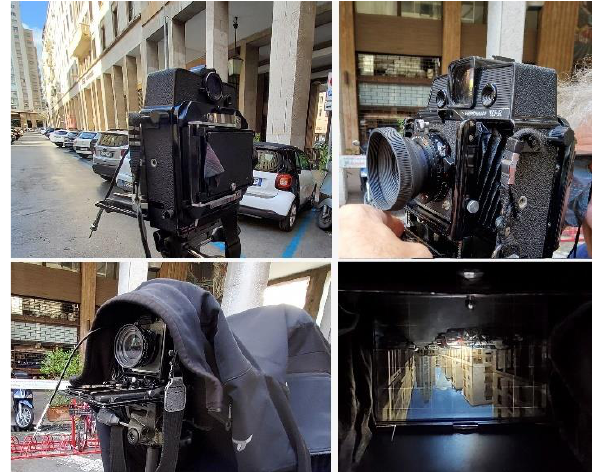
Figure 2: The view camera used for the experiment.